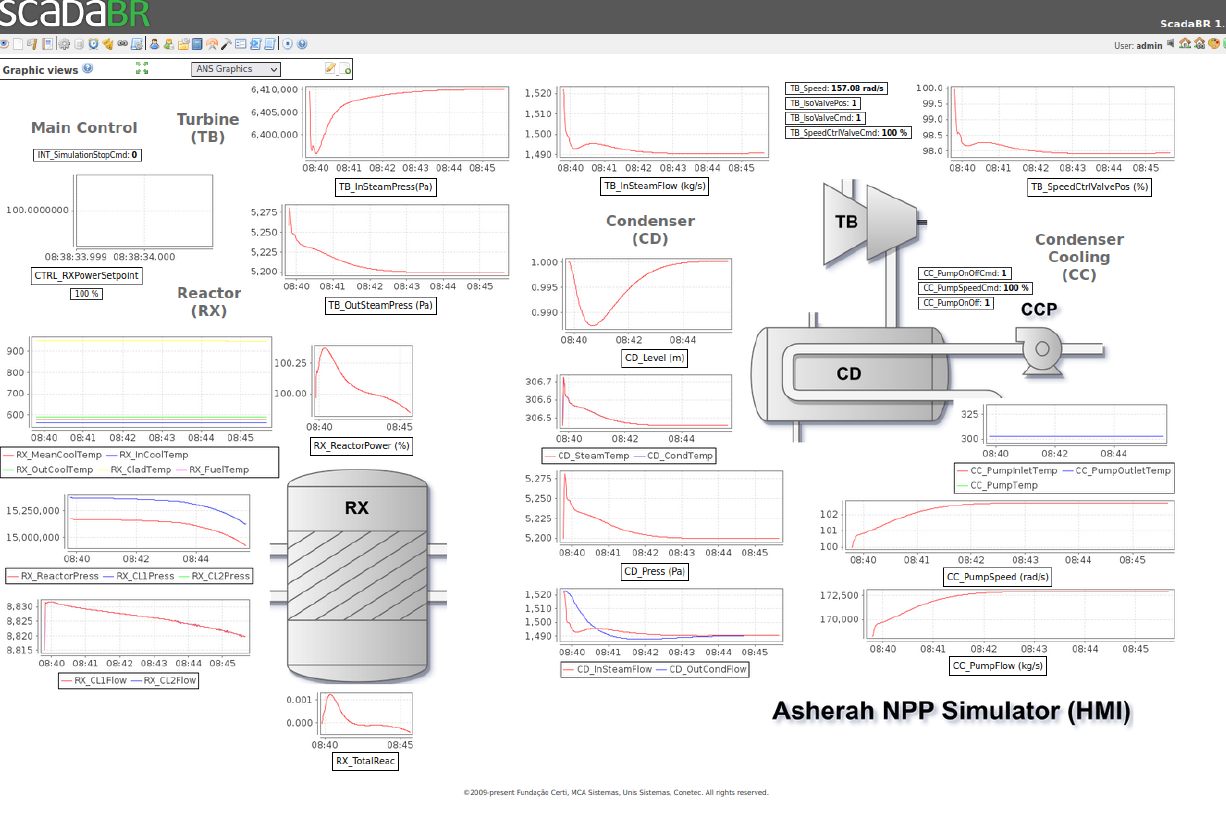
Figure 10. ScadaBR HMI—Synoptic Panel 2